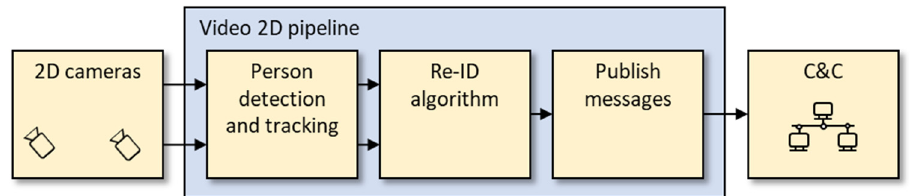
Figure 3. Architecture of 2D Video.